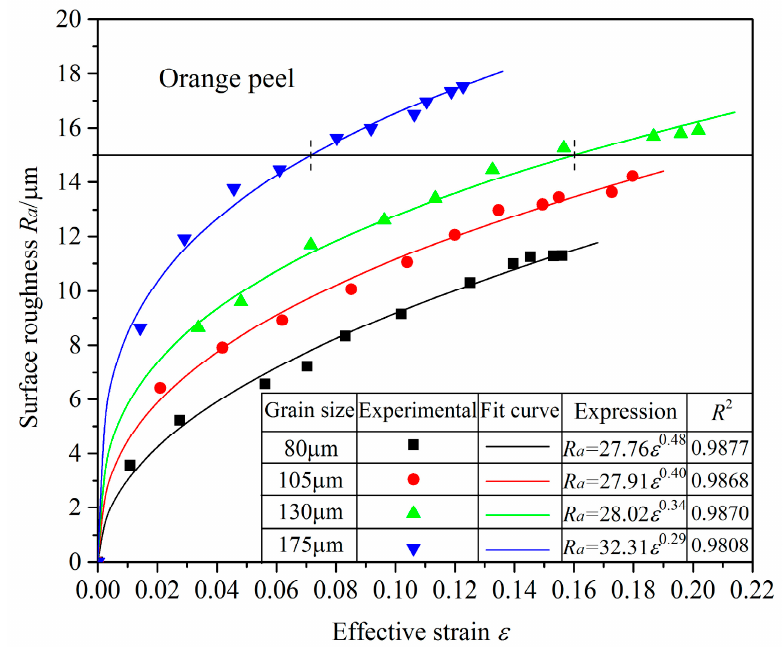
Figure 9. Relationship between surface roughness and effective strain of bulged tubes with different grain sizes. Materials 2017 , 10 , 299